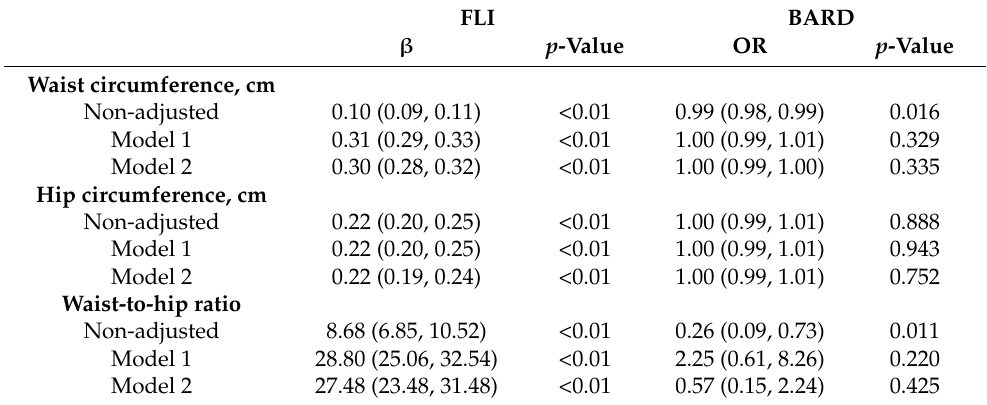
Table 2. Association of waist and hip circumferences and waist-to-hip ratio with FLI and BARD scores. Model 1—adjusted for age and sex; model 2—adjusted for age, sex, BMI, diabetes, and